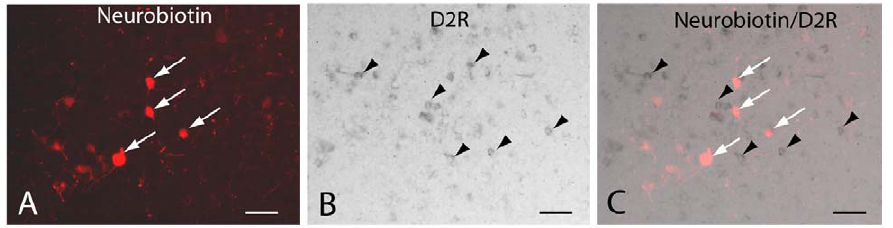
Figure 5. Striatal projection neurons targeting substantia nigra parsreticulata (SNr) do not express the D2 receptor. A. Striatal neurons retrogradely labeled after injections of neurobiotin into the SNr (white arrows). B. DIG-labeled D2 receptor riboprobe expressed in a subpopulation of striatal cells (black arrow heads show examples of positive cells). C. Merged image showing the absence of overlap between retrogradely labeled cells and D2 receptor mRNA expression. Scale bars, 100 m